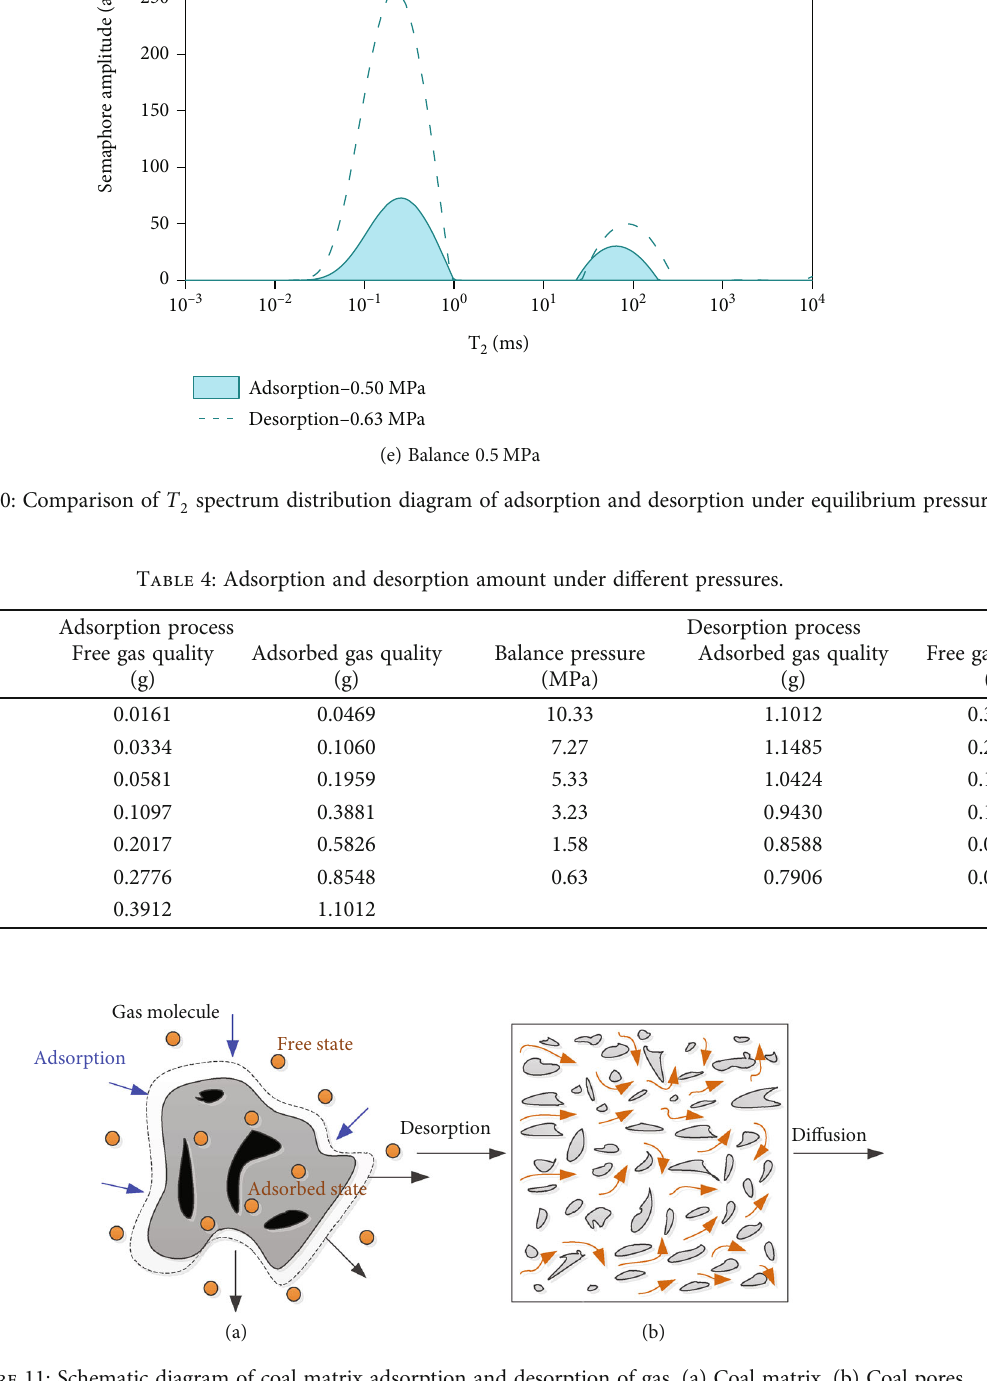
Figure 11: Schematic diagram of coal matrix adsorption and desorption of gas. (a) Coal matrix. (b) Coal methane and represents desorption; the right ordinate axis represents the proportion of adsorbed methane and repre- sents boost adsorption); with the increase of gas pressure, (the left ordinate axis represents the proportion of desorbed